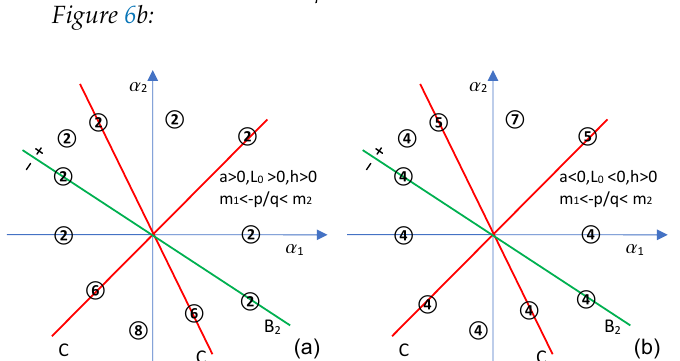
Figure 6. Bifurcation diagrams corresponding to the case: ( a ) a > 0, L 0 > 0, − p ( b ) a < 0, L 0 < 0, − p